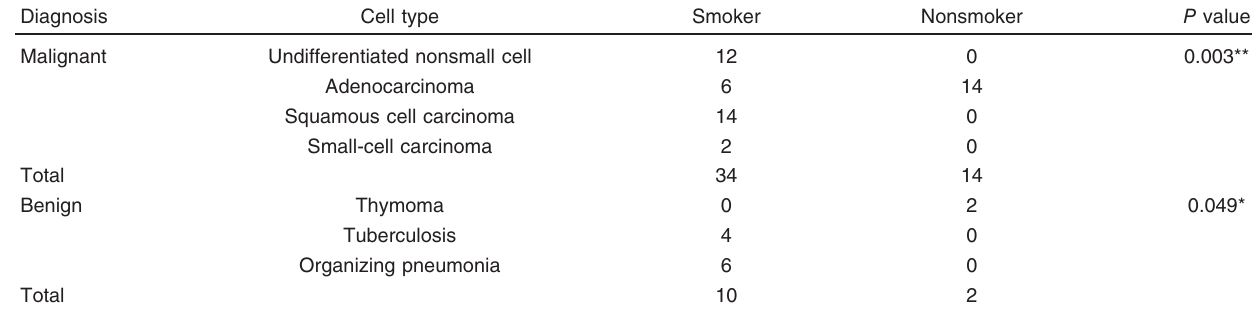
Table 4 Histopathological results in relation to smoking Diagnosis